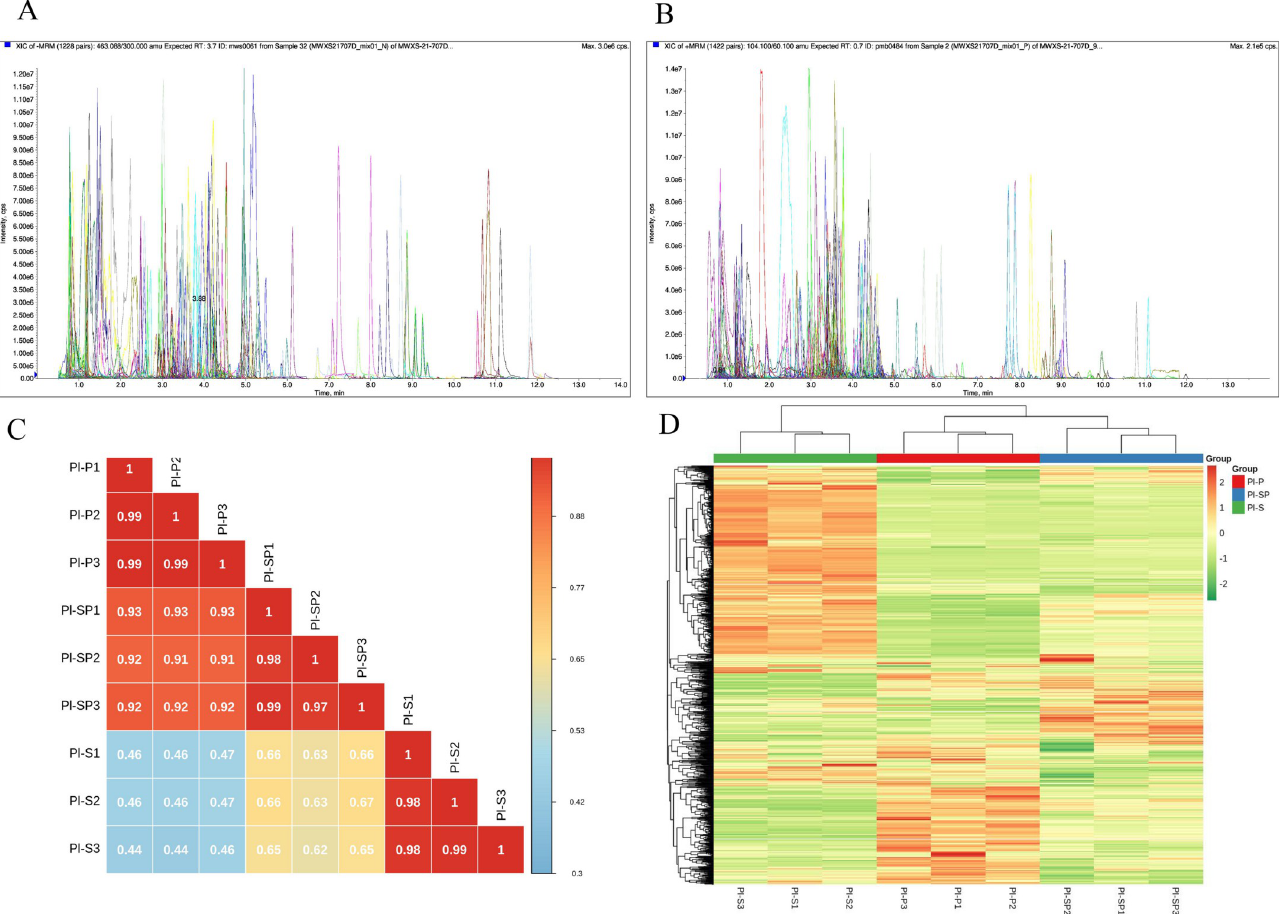
Fig 2. Qualitative and semi-quantitative analysis of metabolites. A-B. Multipeak mass spectral chromatogram of metabolites acquired in negative ion mode (A) and positive ion mode (B). C. Pearson’s correlation coefficients among all the samples. D. Cluster analysis of the identified metabolites.